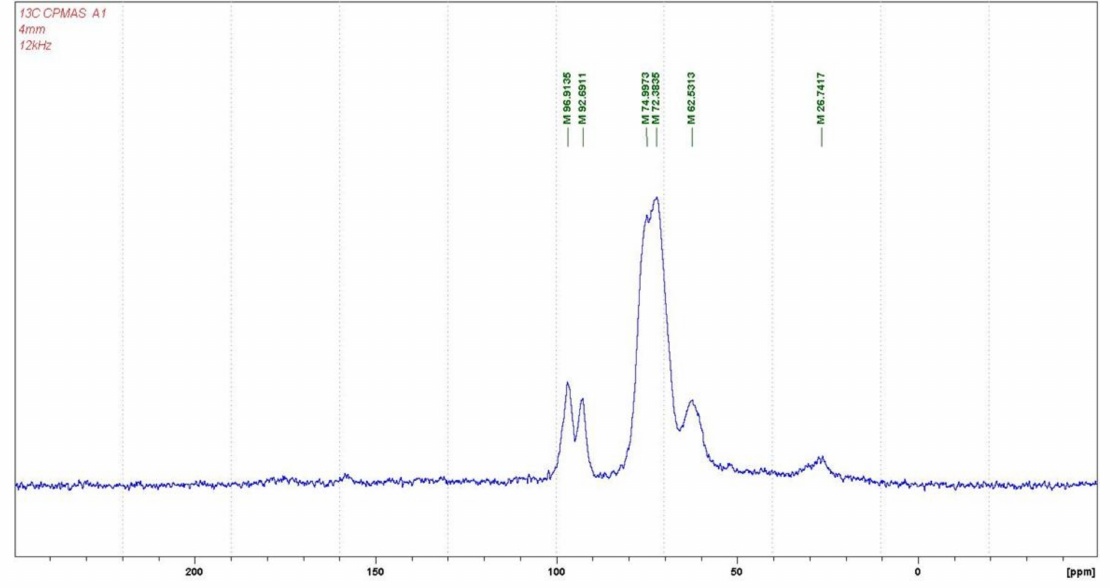
Figure 13. CP-MAS 13 C NMR spectrum of the carbonated glucose